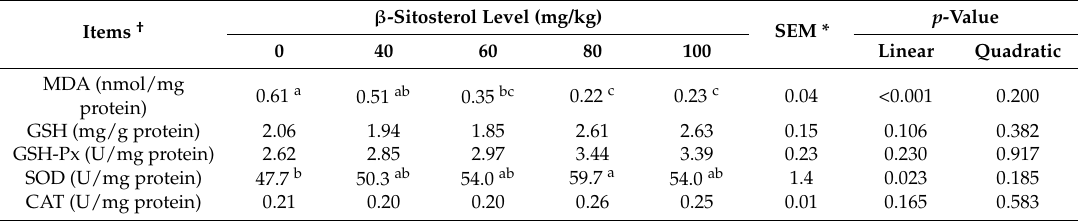
Table 6. Effect of dietary β -sitosterol supplementation at different levels on antioxidant status of breast muscle in broilers.